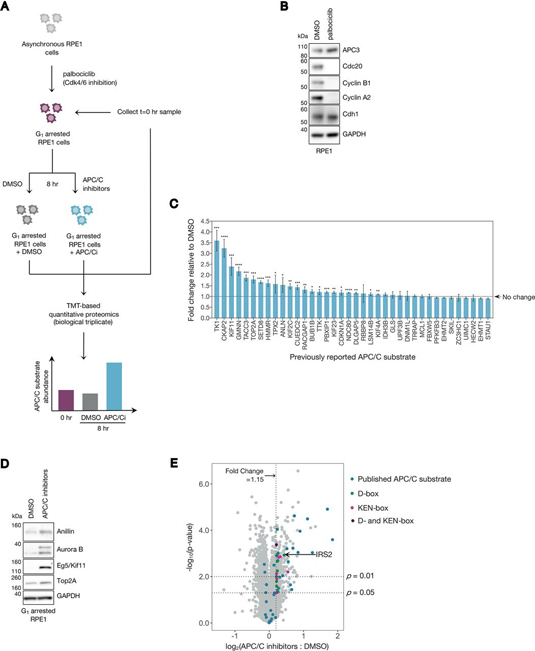
High resolution chemical proteomics reveals proteins whose abundances are APC/C regulated.A, Workflow for the chemical proteomics experiment described in this study. Asynchronous RPE1 cells were arrested in 1 μm palbociclib (a Cdk4/6 inhibitor) for 20 h, at which point they were acutely treated with either DMSO or a combination of 6 μm proTAME + 50 μm apcin (referred to as “APC/C inhibitors” or “APC/Ci”), in the ongoing presence of palbociclib. Cells were then collected at time 0 (the time of APC/C inhibitor addition) or 8 h after drug addition and were harvested for TMT-based proteomic identification and quantification. Samples were analyzed in biological triplicate within a 10-plex TMT label set, with the 10th channel used as a bridge. B, Asynchronous RPE1 cells were treated with either DMSO or 1 μm palbociclib for 20 h. Cells were harvested, and lysates were analyzed by immunoblot for the indicated proteins. C, Previously reported APC/C substrates that were identified in this study are plotted with their observed fold change in the APC/C inhibitor treated sample (APC/Ci) relative to the DMSO treated sample. Error bars represent the standard deviation (S.D.) between the three biological replicates measured by MS. Asterisks indicate an abundance increase over control that is statistically significant (*: p < 0.05; **: p < 0.01; ***: p < 0.001; ****: p < 0.0001) D, Previously reported APC/C substrates that were identified as increasing by MS in G1 RPE1 cells treated with APC/C inhibitors were validated by immunoblot for selected proteins. E, Volcano plot highlighting all published APC/C substrates identified in this study (blue) as well as proteins that (1) contain a high probability D- and/or KEN-box (d-box = green, KEN-box = pink, D- and KEN-boxes = purple), (2) increase ≥1.15-fold under APC inhibition, (3) were identified by >1 peptide, and (4) have a p-value < 0.05.